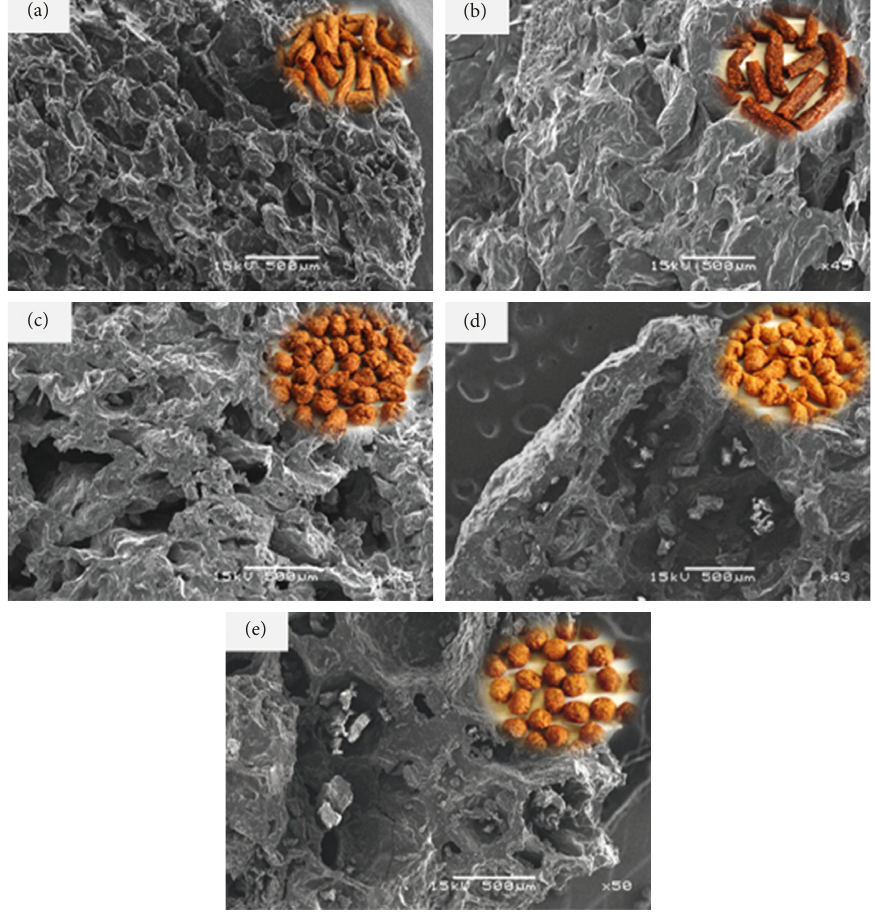
Figure 1: SEM images of the extruded breakfast products made from oca flour. Sample ID: (a) F20/O80/M20; (b) F0/O100/M20; (c) F10/ O90/M17.5; (d) F20/O80/M13; and (e) F0/O100/M13. For sample IDs, refer to Table